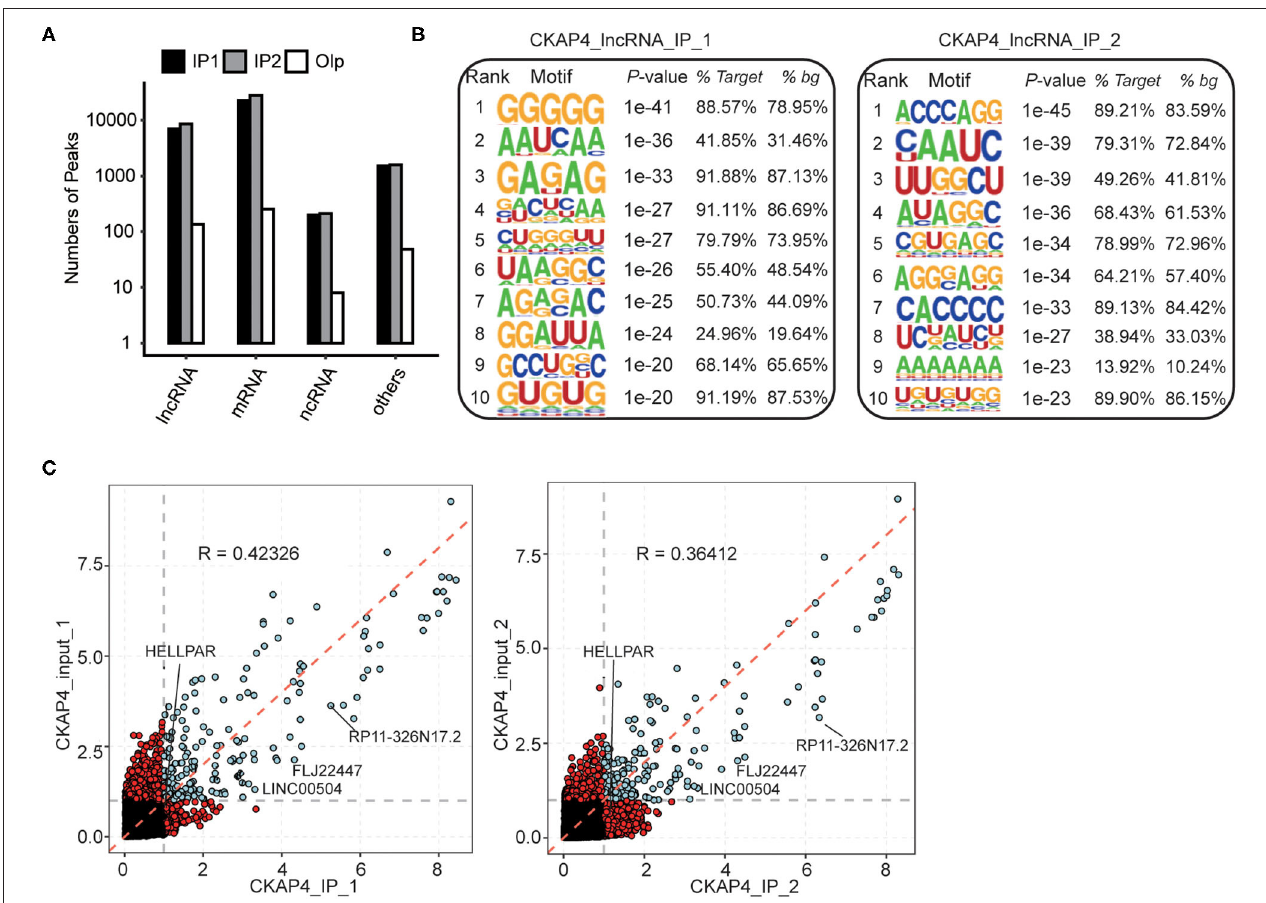
FIGURE 3 | Peak analysis revealed the lncRNA-binding features of CKAP4. (A) Bar plot showed the peak numbers of different RNA types. (B) Motif analysis showed the top 10 preferred bound motifs of lncRNAs by HOMER software. (C) Scatter plot showed the gene RPKM (Reads per kilo base of a gene per million reads) in paired samples. Red points represented the specifically expressed genes in IP or input